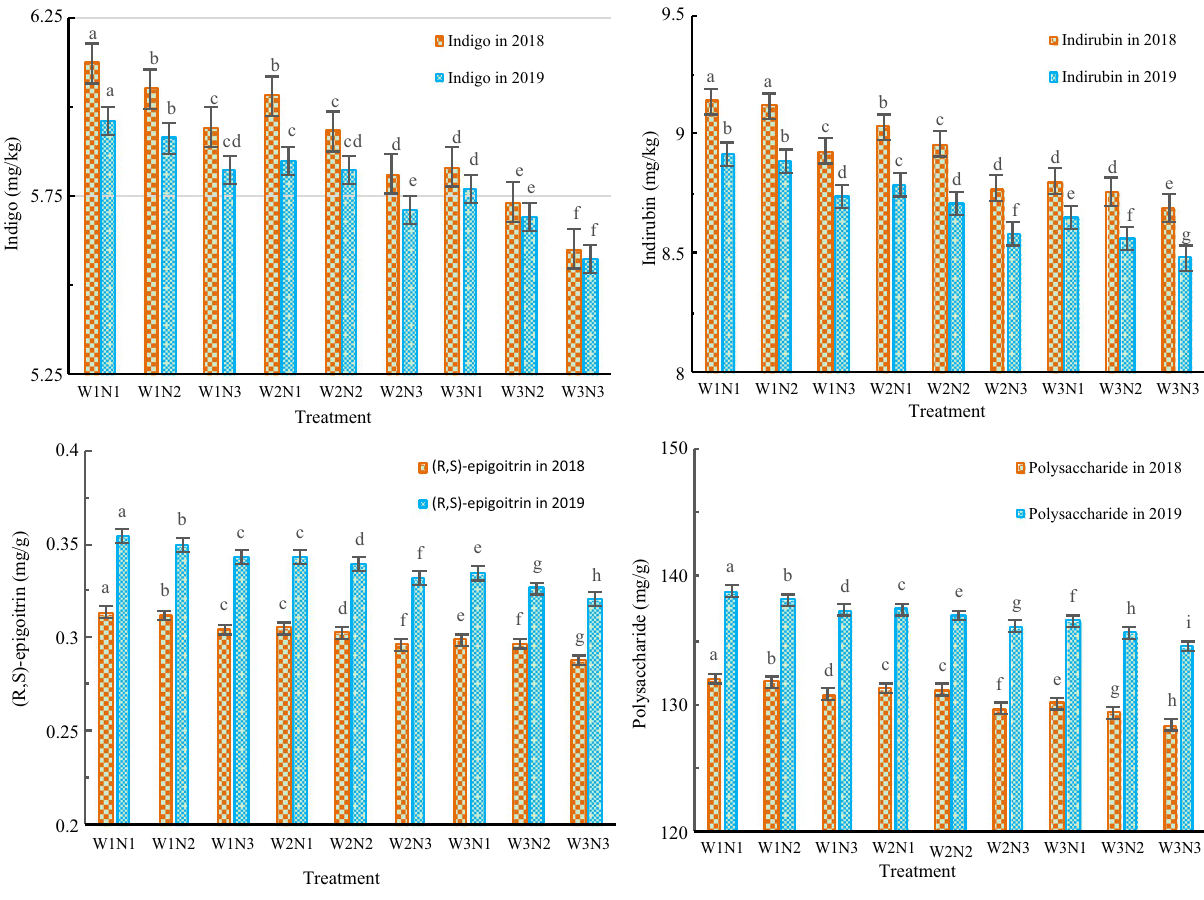
Figure 5. The effects of the different treatments on the quality index of Isatis indigotica . The values shown are the mean ± SD, n = 3. Asterisks indicate a significant difference at the P ≤ 0.05 level.